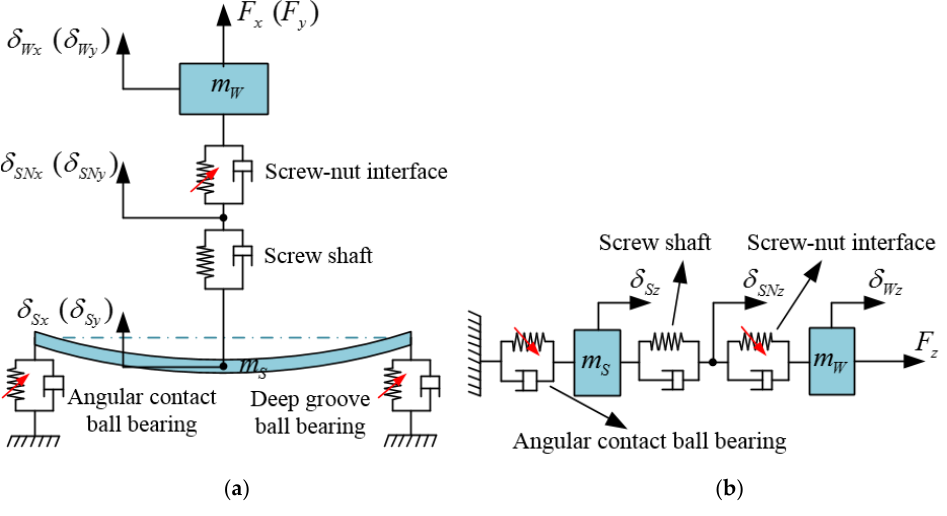
Figure 6. Nine degree-of-freedom dynamic model for feed system: ( a ) x ( y )-axis direction; ( b ) z - axis direction.